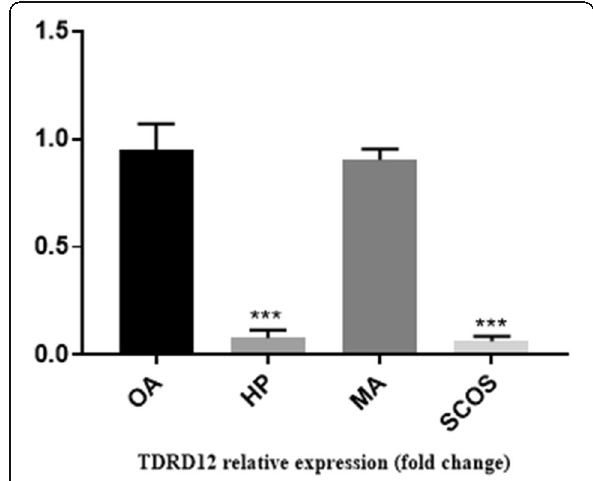
Fig. 6 Comparison of the expression levels of TDRD12 between HP, MA, SCOS, and OA(control) patients. *** p < 0.001